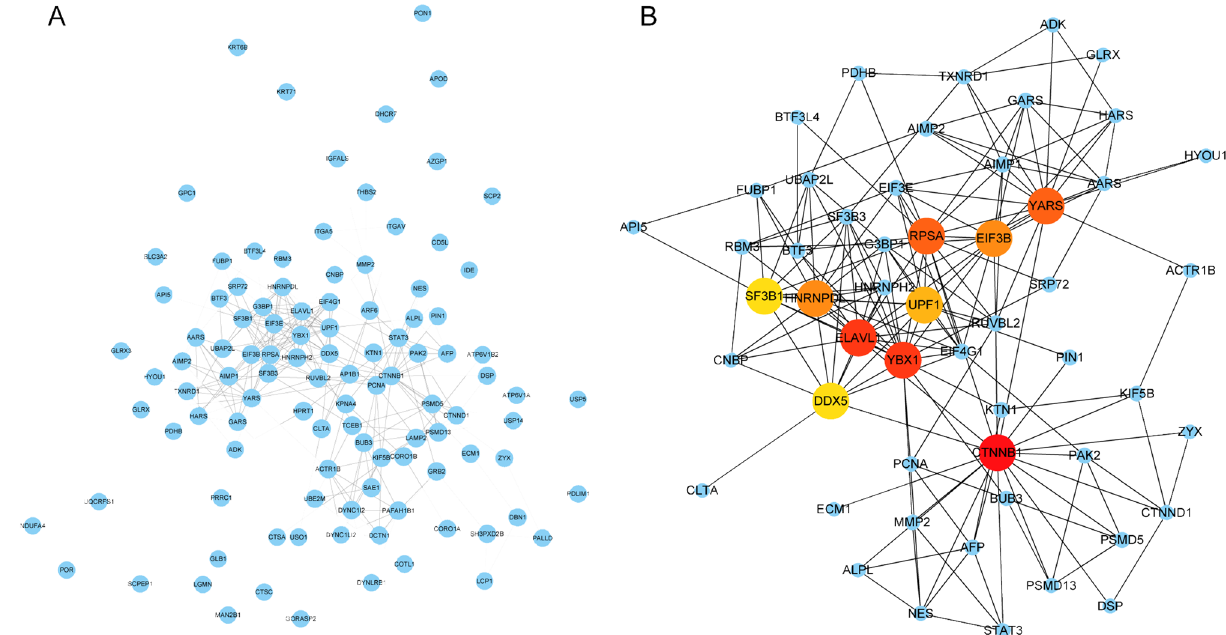
Figure 4. The PPI network for antler-special proteins constructed by STRING and Cytoscape. ( A ) The whole network including 107 nodes and 289 edges. The disconnected proteins in the network did not be showed. ( B ) Sub-network of top ten hub proteins with their expanded network.